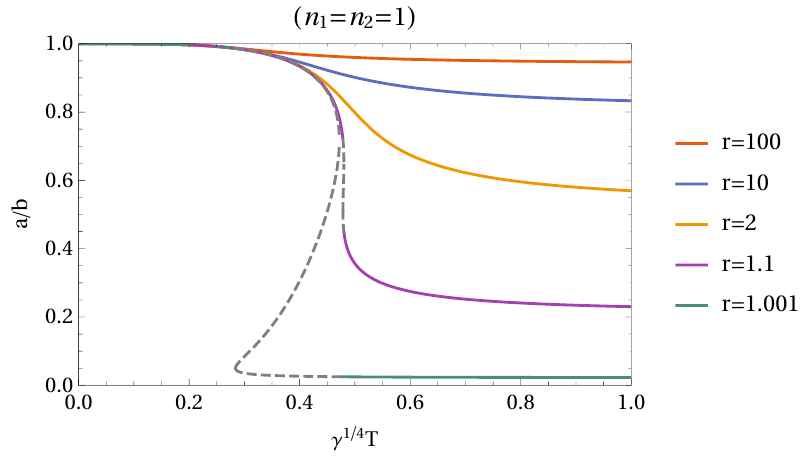
Figure 2 . E(cid:11)ective light-cone speeds of the two subsystems with n 1 = n 2 = 1 and di(cid:11)erent values of r = (cid:0) (cid:13) 0 =(cid:13) . Above r = r c (cid:25) 1 : 1145 there is a unique solution for all values of (cid:13) 1 = 4 T (full lines), while below r c there are ranges of (cid:13) 1 = 4 T with three solutions (dashed